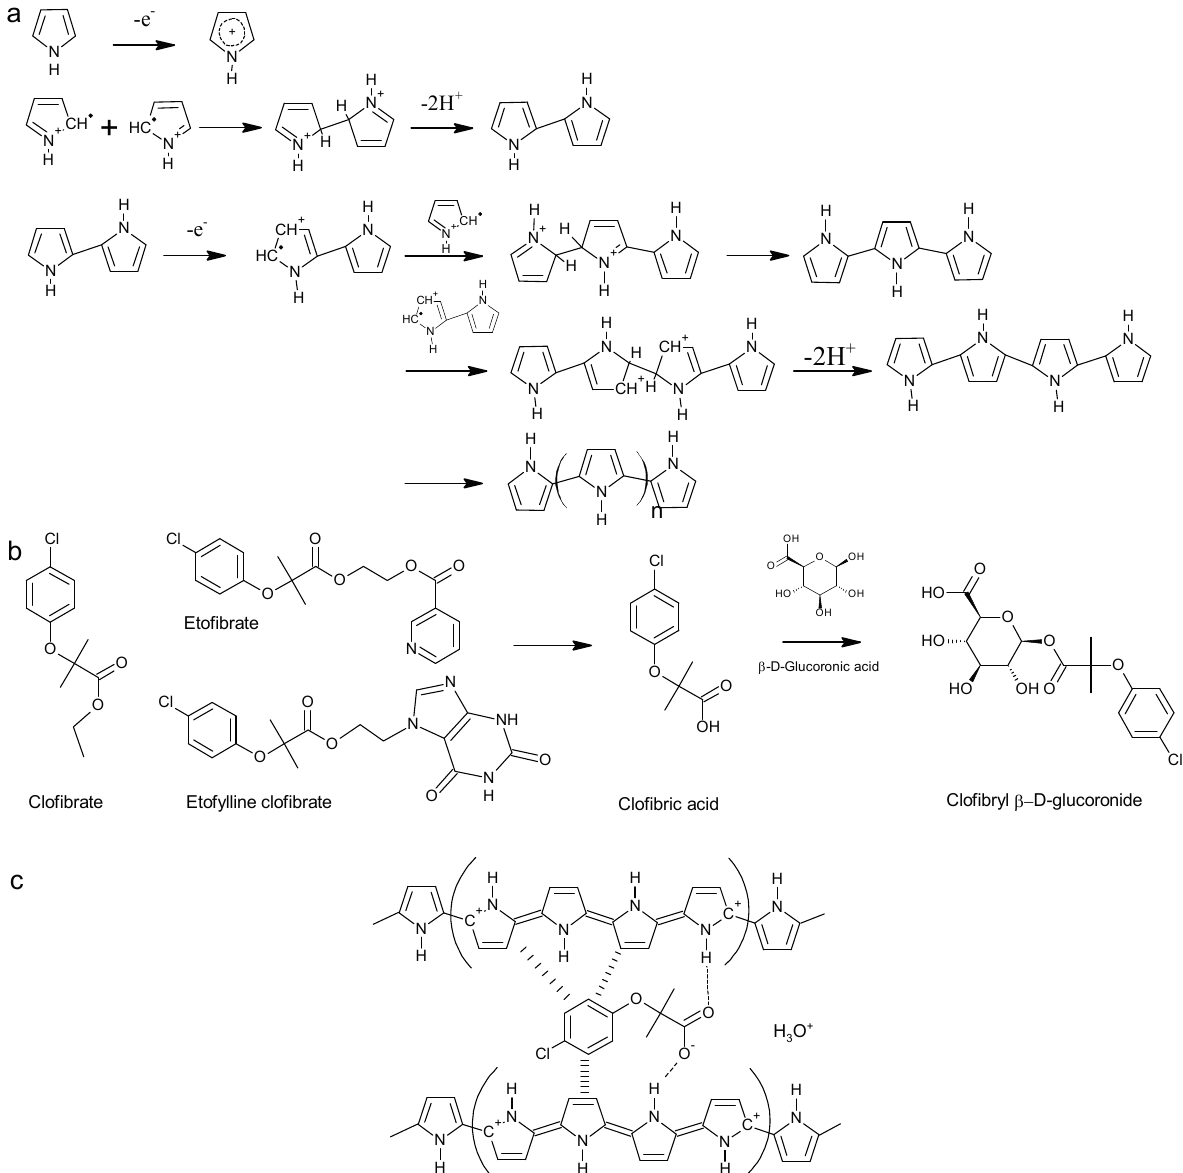
Figure 1. ( a ) Overview on polymerization reactions of pyrrole; ( b ) Precursors and